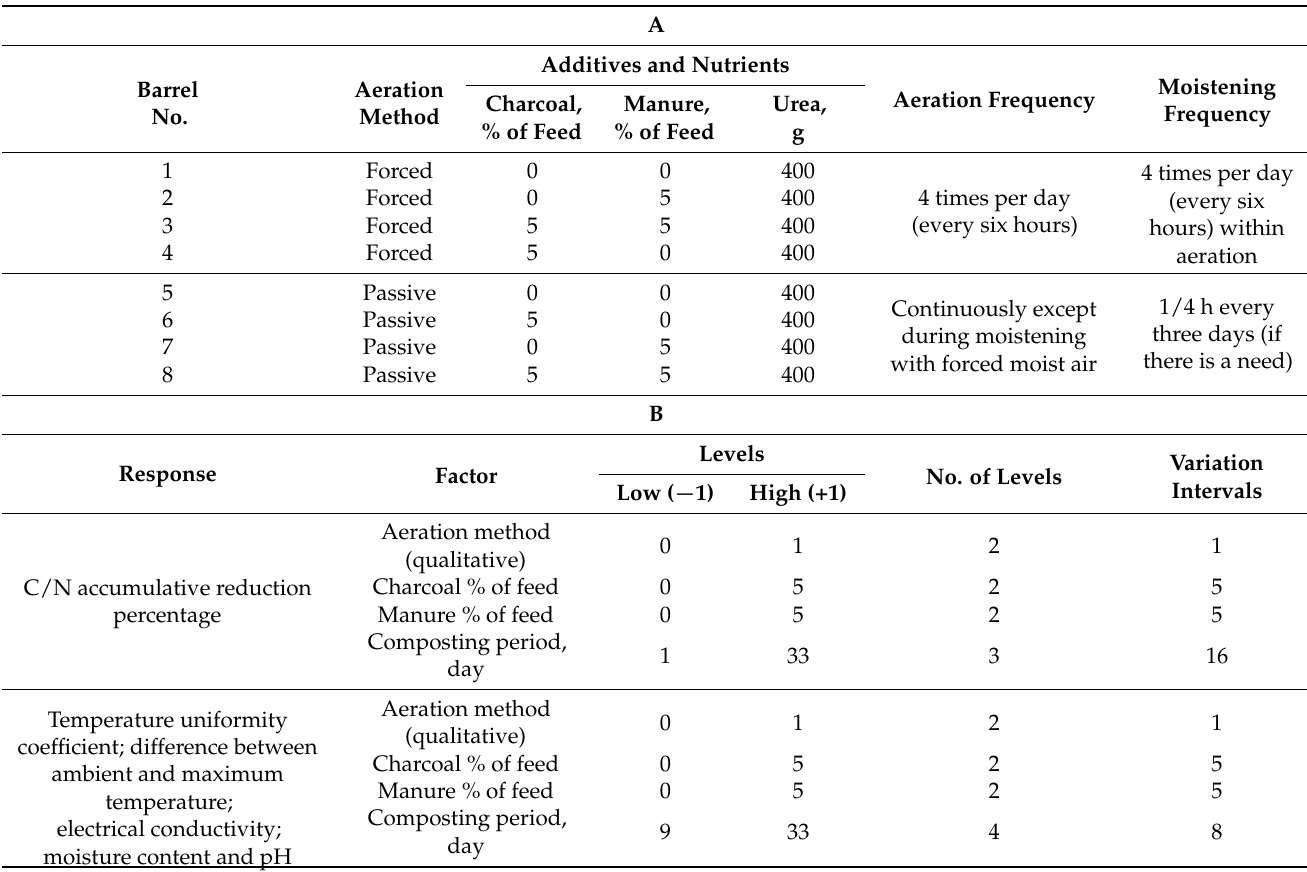
Figure 4. Perspective view showing an approximate placement of temperature digital sensors through barrels and ambient (A) box containing DAQ for data logging, (B) flipped barrel as a stand for DAQ box, (C) ball valve, (D) air and water vapor mixture inlet, (E) air and water vapor mixture outlet furnished for manual piping, (F) hose piped to (Part: E). Table 1. A. Experimental design of each barrel. B. Levels and variation intervals of each factor in the experimental design. C. chemical composition of citrus wood charcoal (Abu Bakr,